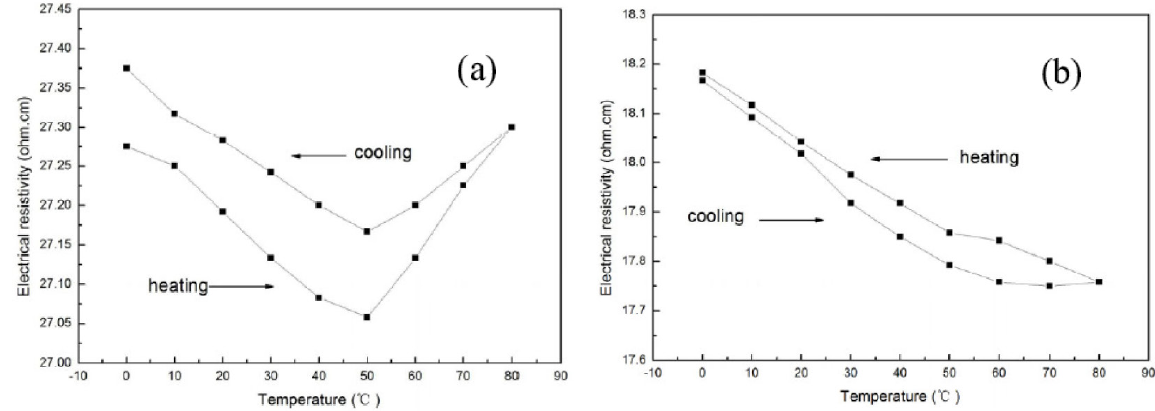
Figure 16: Resistivity-temperature characteristics during the heating and cooling of a cement paste containing (a) 0.4wt.% CNFs; (b) 0.4wt.%CNFs and 1.5wt.% CNTs